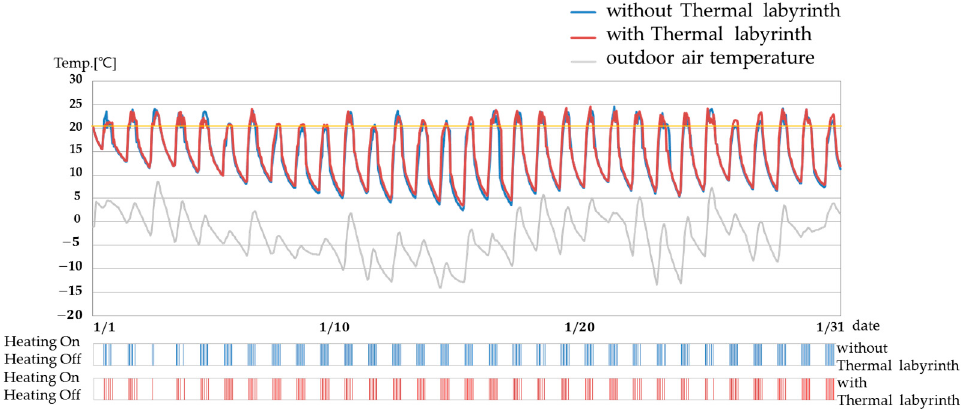
Figure 15. Outdoor and indoor air temperature distributions during heating.